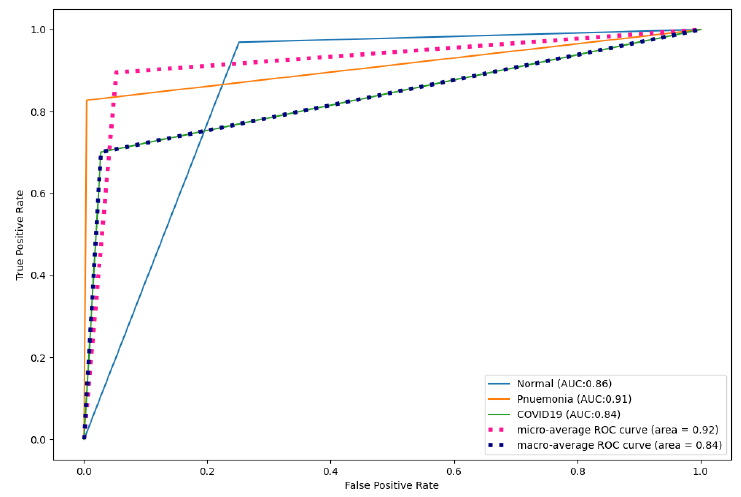
Figure 17. CNN ROC curves for X-ray images.